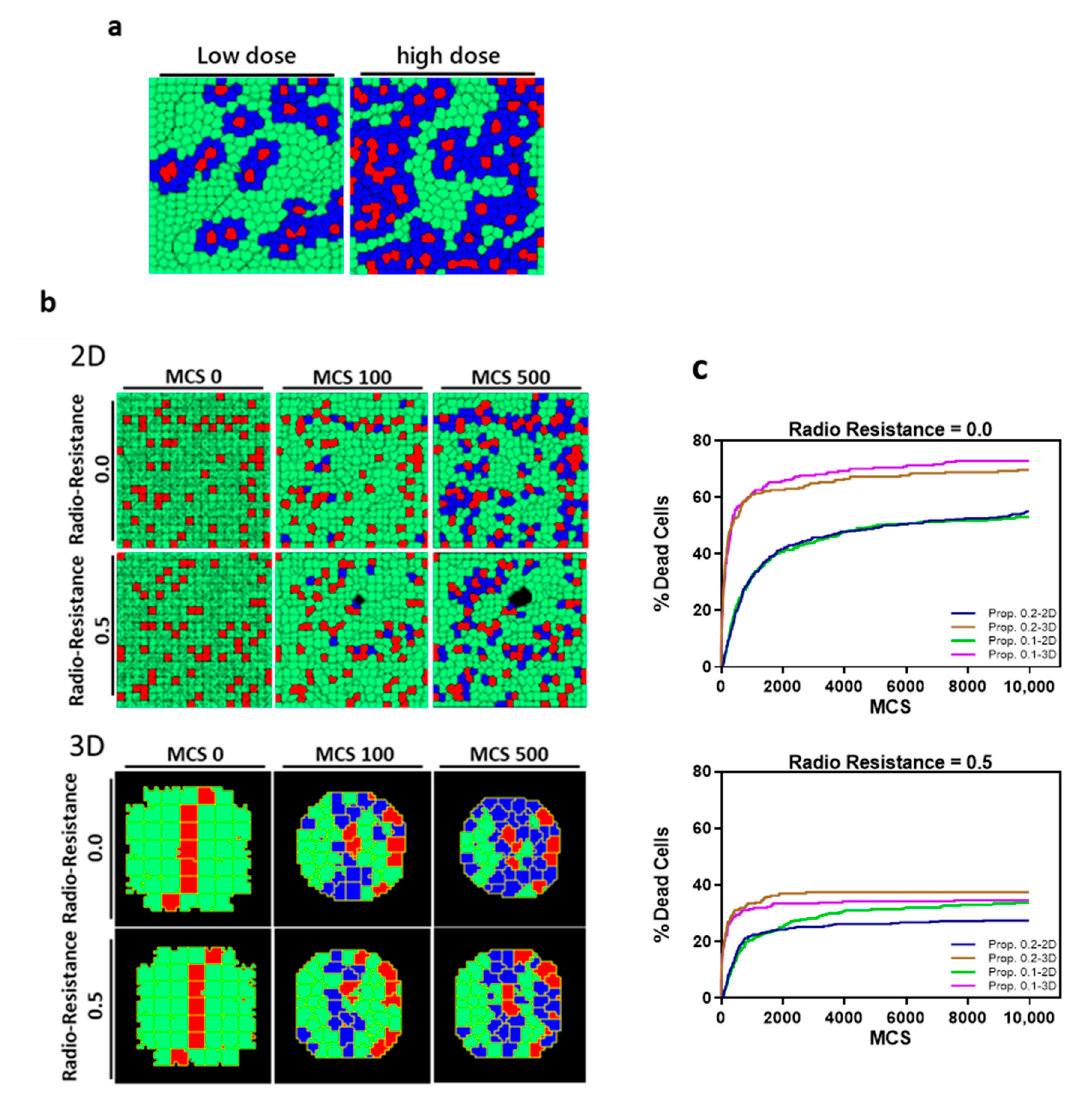
Figure 6. The predicted probability of BNCT treatment outcome through Monte Carlo simulation. ( a ) Proposed dose definitions in 2D and 3D model simulations with live tumor cells (green), dead cells (blue) and BPA-containing cells (red). ( b ) Representative images at successive Monte Carlo Timesteps (MCS) of cell death in 2D and 3D models post irradiation with high dose. ( c ) Cell death count in 2D sheets and 3D tumoroids of pancreatic tumor cells after BNCT treatment with different radioresistance thresholds (0.0 and 0.5) at varying particle propagation constants (0.1 and 0.2 pixel 2 /MCS).